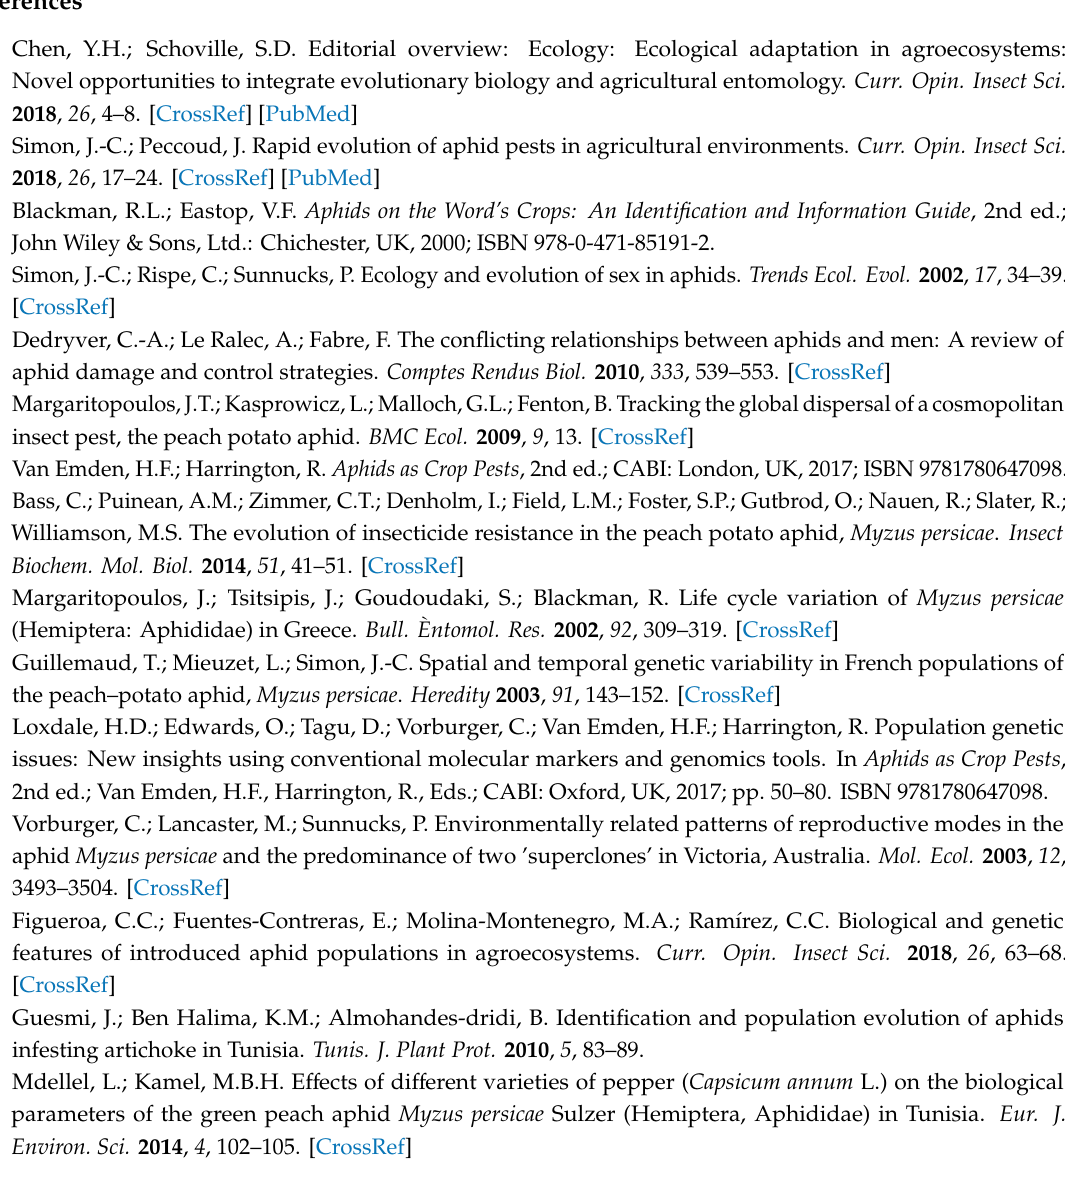
Figure S1: Bayesian population structure analysis used for assigning 397 MLGs and 19 Tunisian populations of Myzus persicae to di ff erent genetic clusters. The clustering was performed using an admixture model with correlated allele frequencies; Table S1: Allele combinations for each of the 548 aphid individuals of Myzus persicae sampled in Tunisia from 2011 to 2016; Table S2: Polymorphism detected for each microsatellite locus on samples of Myzus persicae in